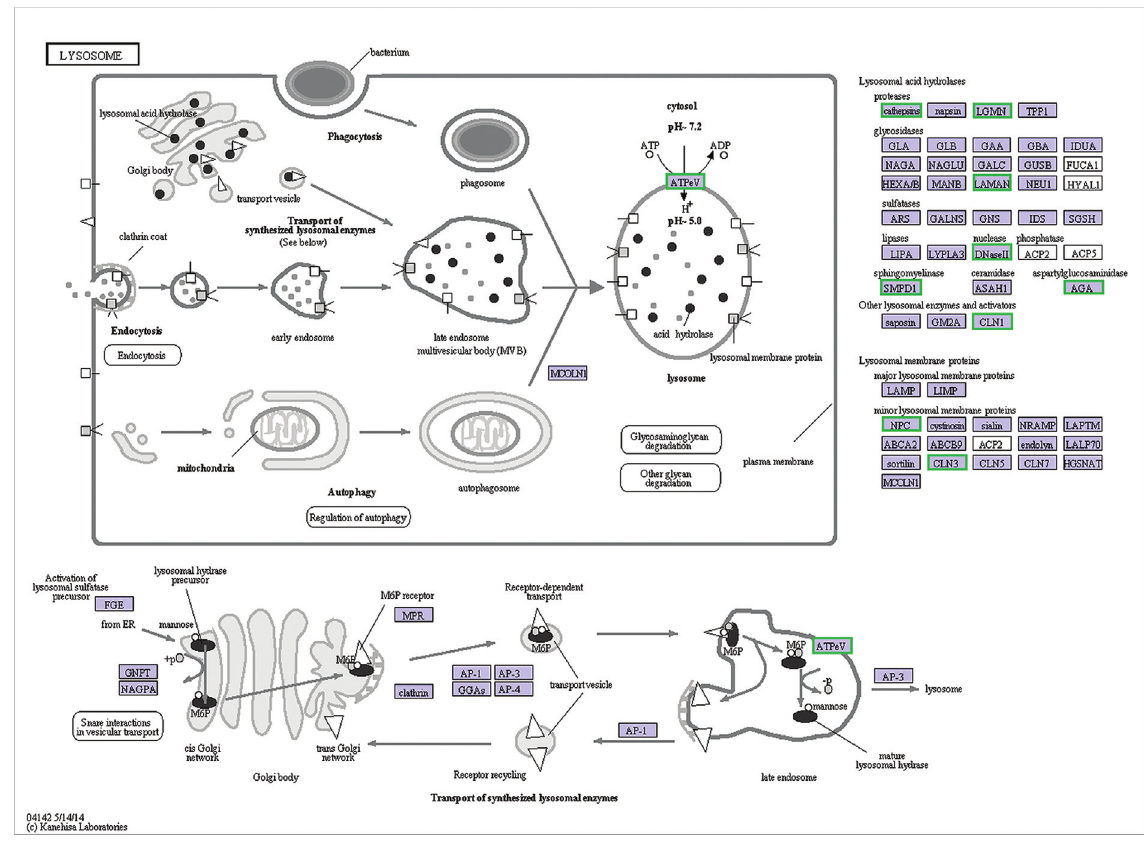
Figure 8 - Unigenes predicted to be involved in the lysosomal pathway. Green represents down-regulated unigenes in female adults compared to